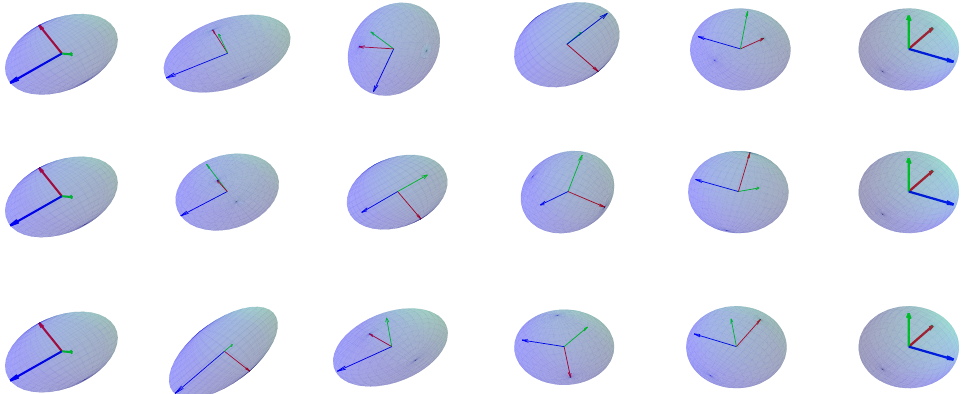
Figure 5. Discrete-time observations from three sample paths on SPD ( 3 ) . The sample paths are obtained as the pushforward of the Fermi bridge in GL + ( 3 ) . The start and endpoint are the left- and rightmost figures, where the SPD matrices are indicated by the bold face arrows.